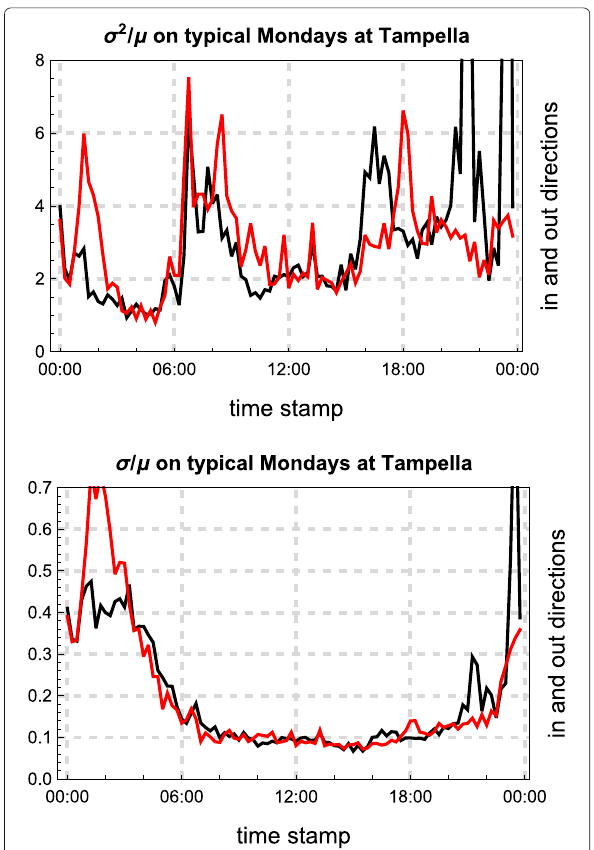
Fig. 2 The index of dispersion (IDC, σ 2 /μ ,upper) and the coefficient of variation (CoV, σ/μ , lower) of the observed vehicle counts are illustrated on normal working day Mondays at Tampella measurement point. Inbound and outbound traffic are illustrated in black and red,